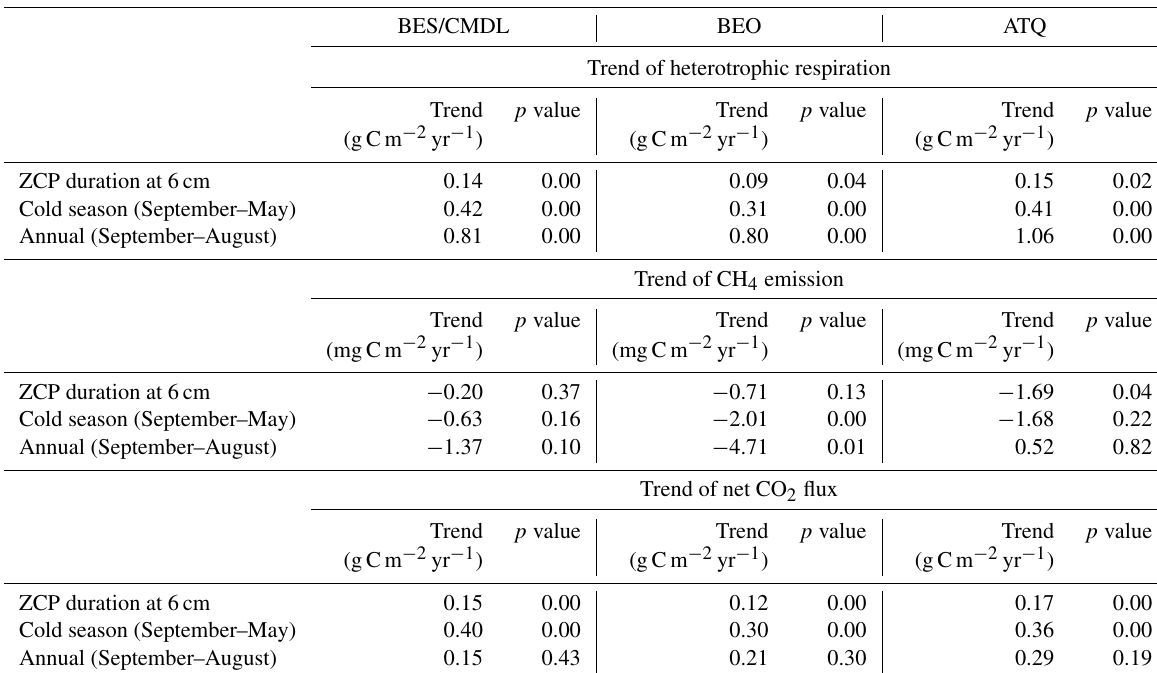
Table 6. Historical trend (1950–2017) in site-scale heterotrophic respiration, CH 4 emission, and CO 2 flux during the ZCP duration at 6cm (third layer), cold-season months (September–May), and the whole annual cycle (September–August). (Trends with p> 0 . 05 are not statistically